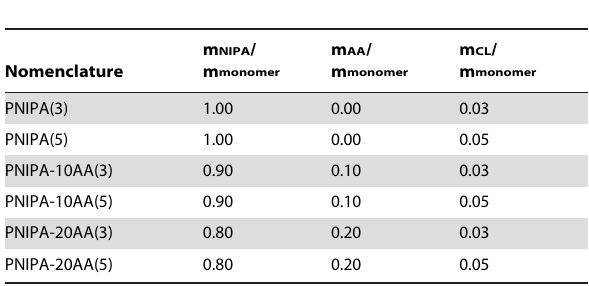
Table 1. Composition of the PNIPA/AA